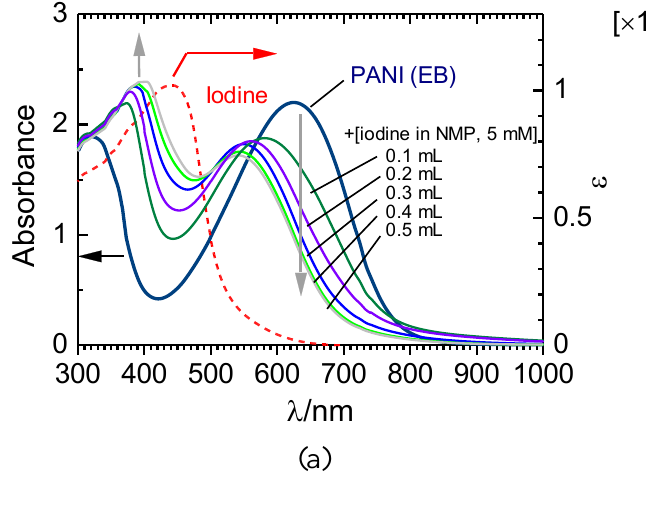
Figure 6. Optical absorption spectra of PANI (EB) in N -methyl-2-pyrrolidone (NMP) ( a ), iodine in NMP solution and PANI (EB) with iodine doping in NMP. CIE color space chromaticity diagram of PANI (EB) with iodine doping and iodine in NMP ( b